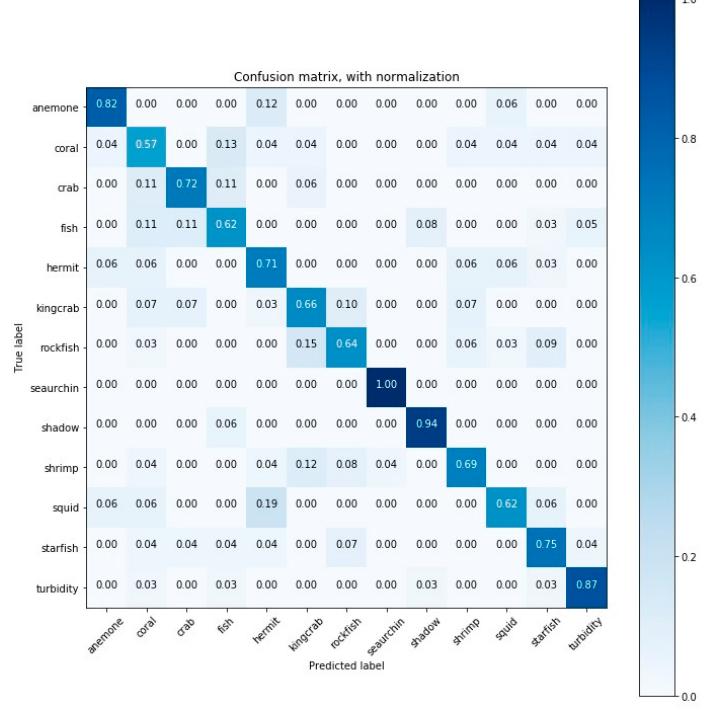
Figure A12. Confusion matrix for the classification results (accuracy) obtained by DNN-2.